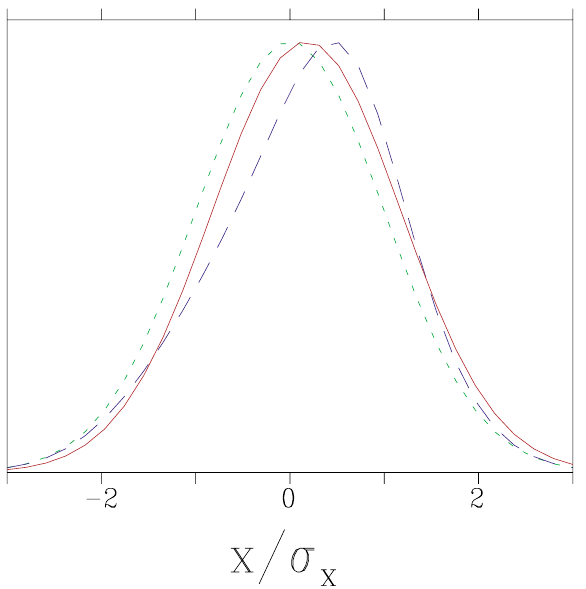
FIG. 2. (Color) Beam profile during coherent oscillation. The horizontal axis is the horizontal coordinate x . The dotted curve is the equilibrium distribution, the dashed curve the real distri- bution in oscillation, and the solid curve its Gaussian approxi- mation.